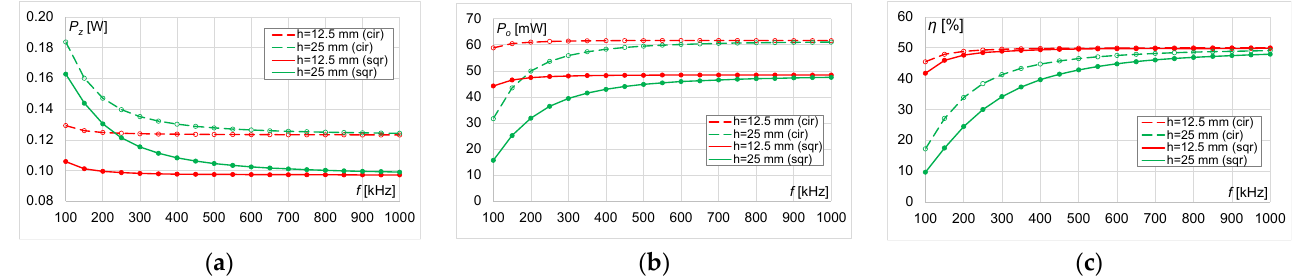
Figure 25. Results for circular and square coils with r = 25 mm and number of turns n = 60 at different distances ( h = 12.5 mm and h = 25 mm): ( a ) transmitter power, ( b ) receiver power and ( c ) power transfer efficiency.